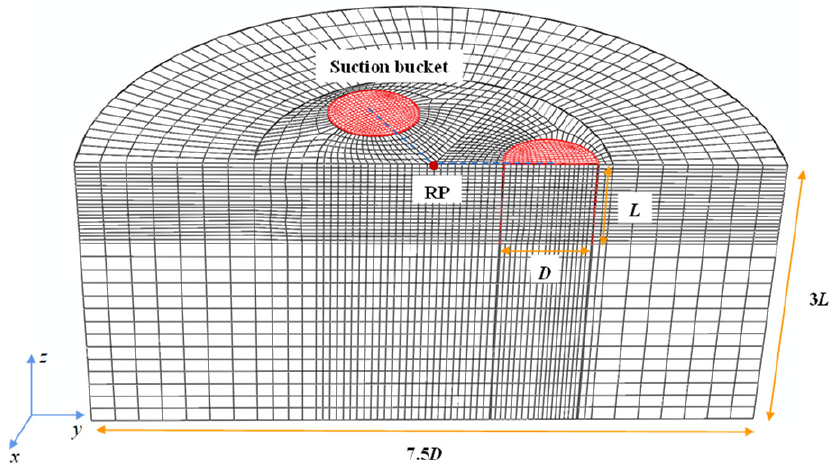
Figure 10. Finite element model of a tripod suction bucket foundation.